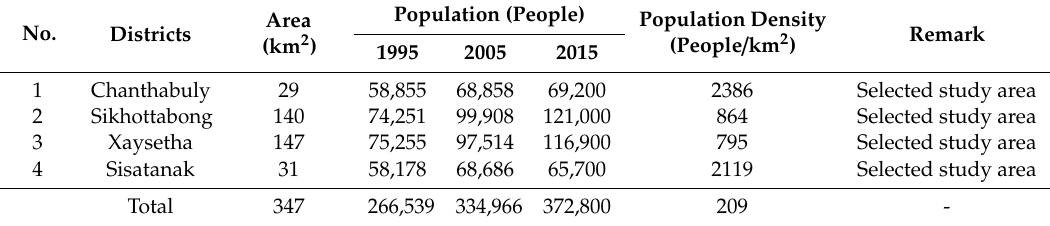
Figure 1. The map of Vientiane, Laos, with the study area and district information. Table 1. Population in the study area districts of